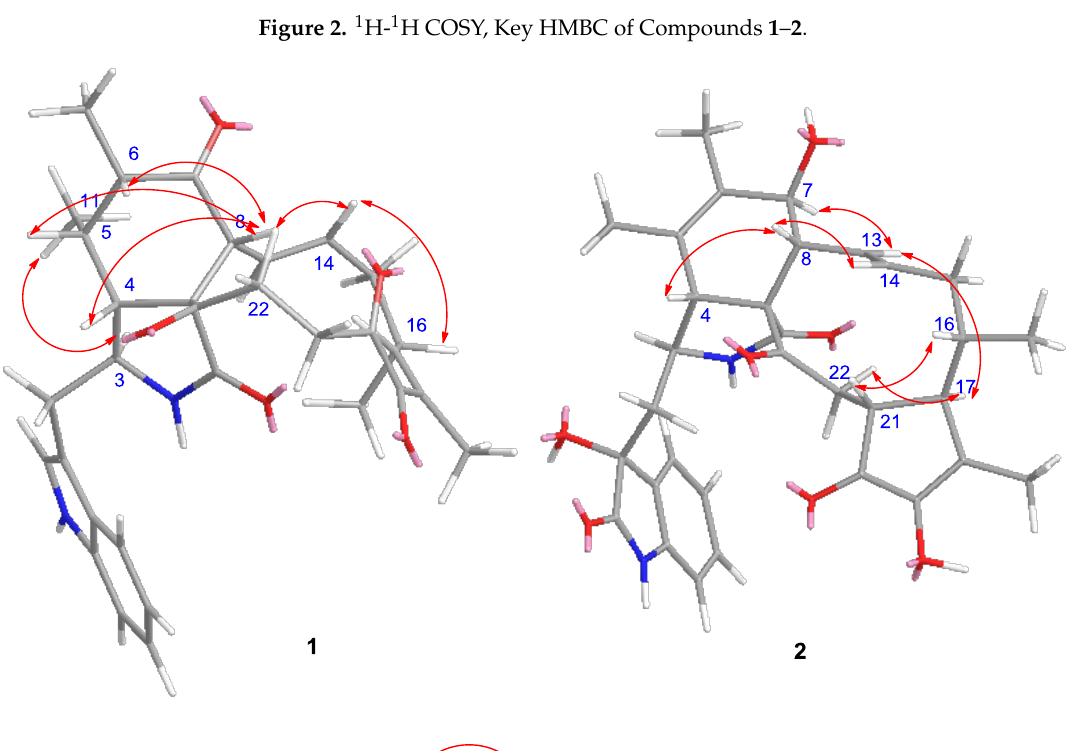
Figure 3. Key NOESY correlations of Compounds 1 – 2 .